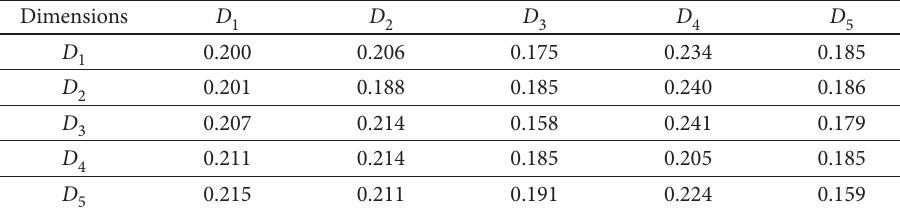
Table B5. Normalized dimensional matrix N D T Dimensions